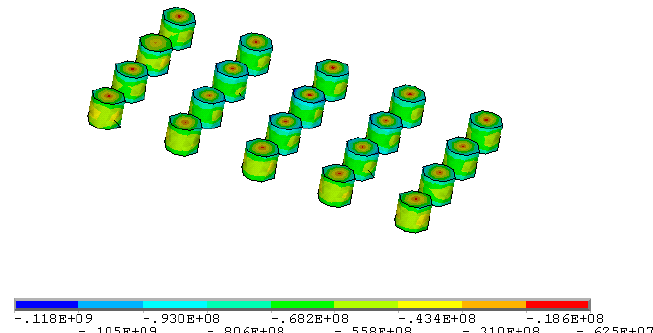
Figure 20. Maximum principal stress distribution in the middle of the pillar at 1480 mL of scheme 2 (parameters of scheme 2: stope height 2.5 m, pillar diameter 3 m, pillar spacing 6 m, pillar row spac- ing 8 m).